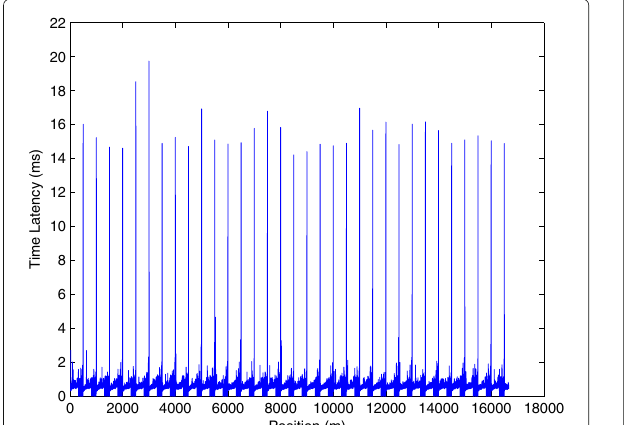
Fig. 13 Time delay versus the location of the train